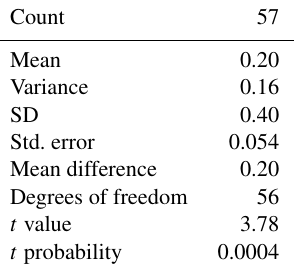
Table 1. Results of the Student’s t -test for a single group. Testing the δ 18 O F - δ 18 O shell- F . Test value: 0 (testing whether the difference between δ 18 O F and δ 18 O shell- F is statistically equal to